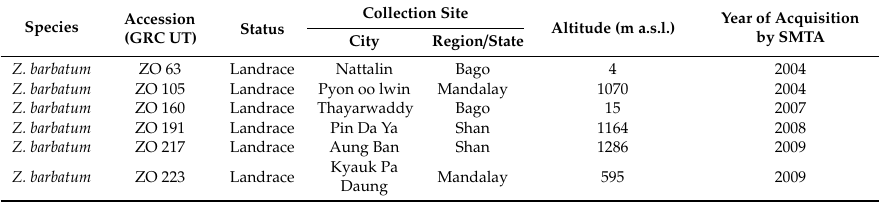
Table A1. List of accessions, the appropriate identification code number, the plant origins, and collection